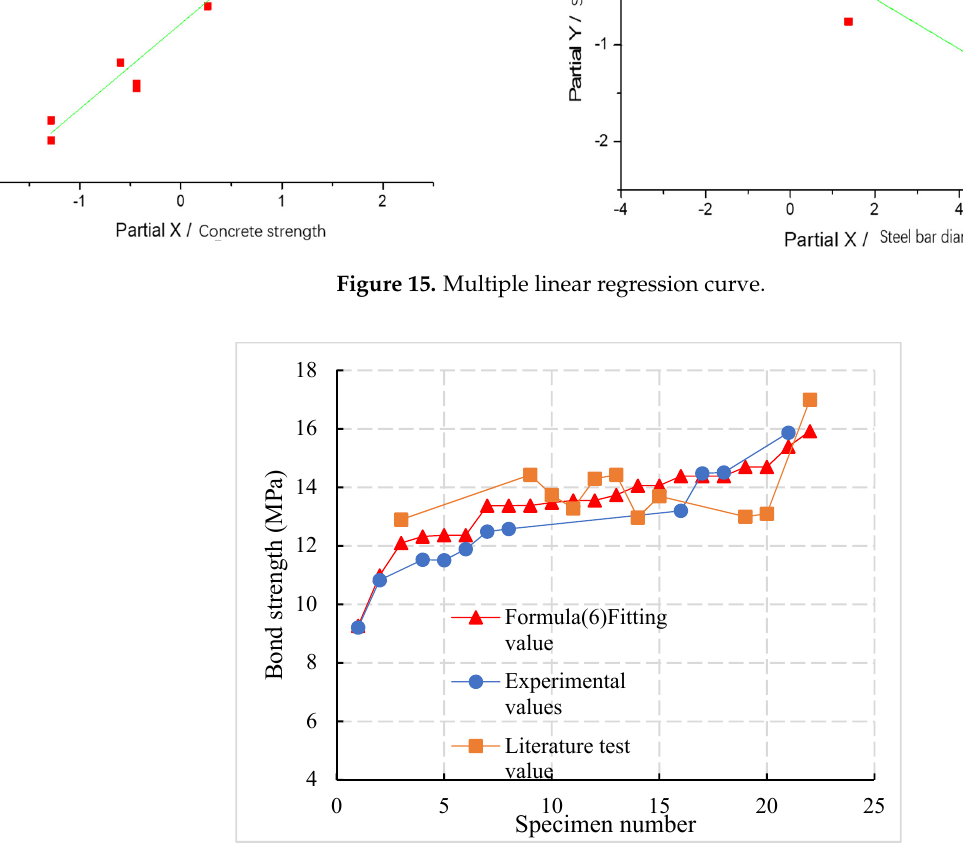
Figure 16. Comparison curve between fitting value and test value of bond strength.